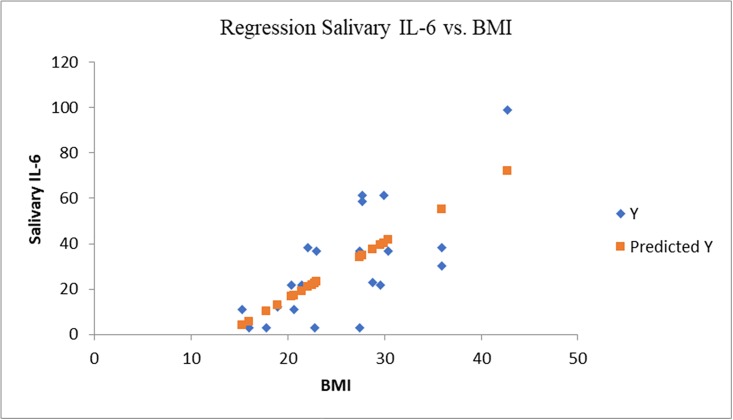
Statistical regression IL-6 vs. BMI (multiple r = 0.71, r square = 0.51).